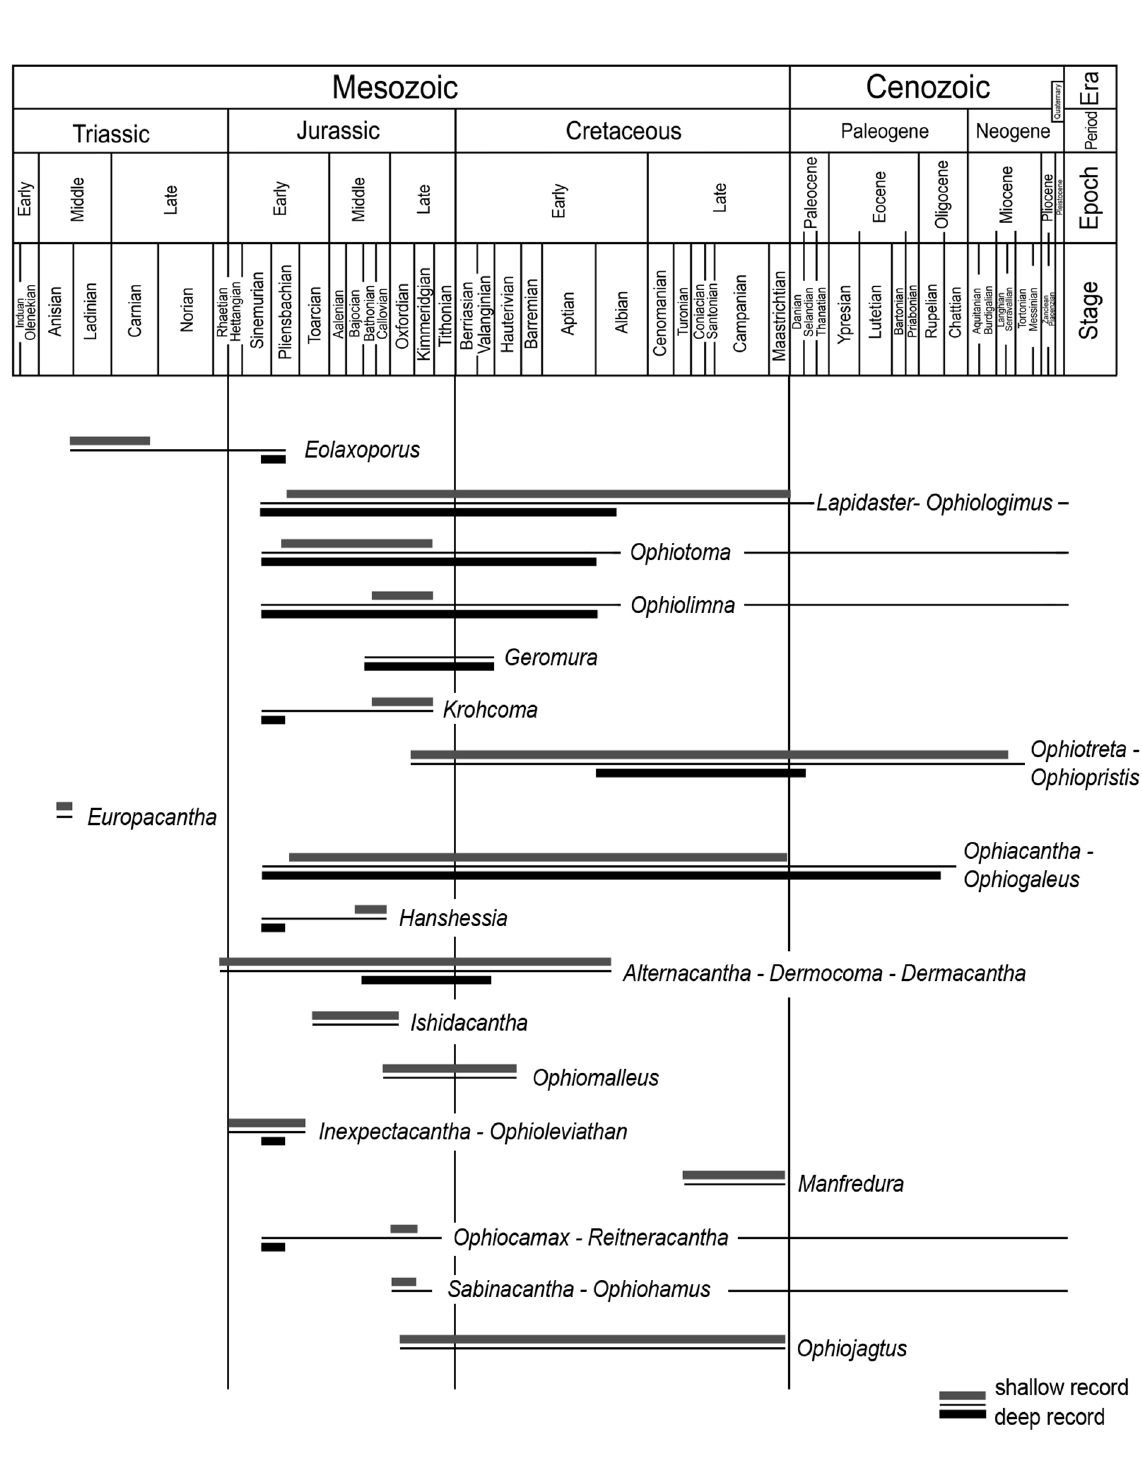
Fig. 1. Ophiacanthid brittle star lineages and their fossil record in shallow (< 200 m palaeodepth, thick grey lines) and deep (> 200 m palaeodepth, thick black lines) environments through time. Extant lineages are indicated by the thin median line extending to the